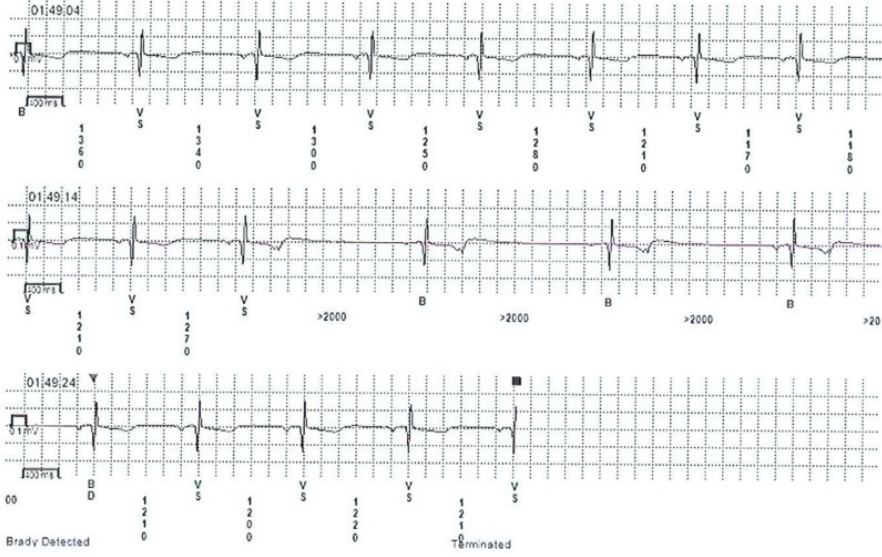
Figure 2. Implantable loop recorder tracing revealing cardioinhibitory response during presyncope in a patient with neurally mediated syncope.